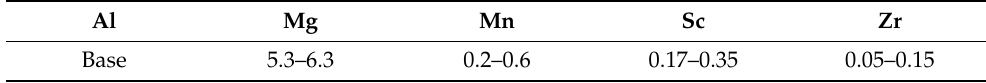
Table 1. Chemical composition of Al-Mg-Sc alloy, wt%.